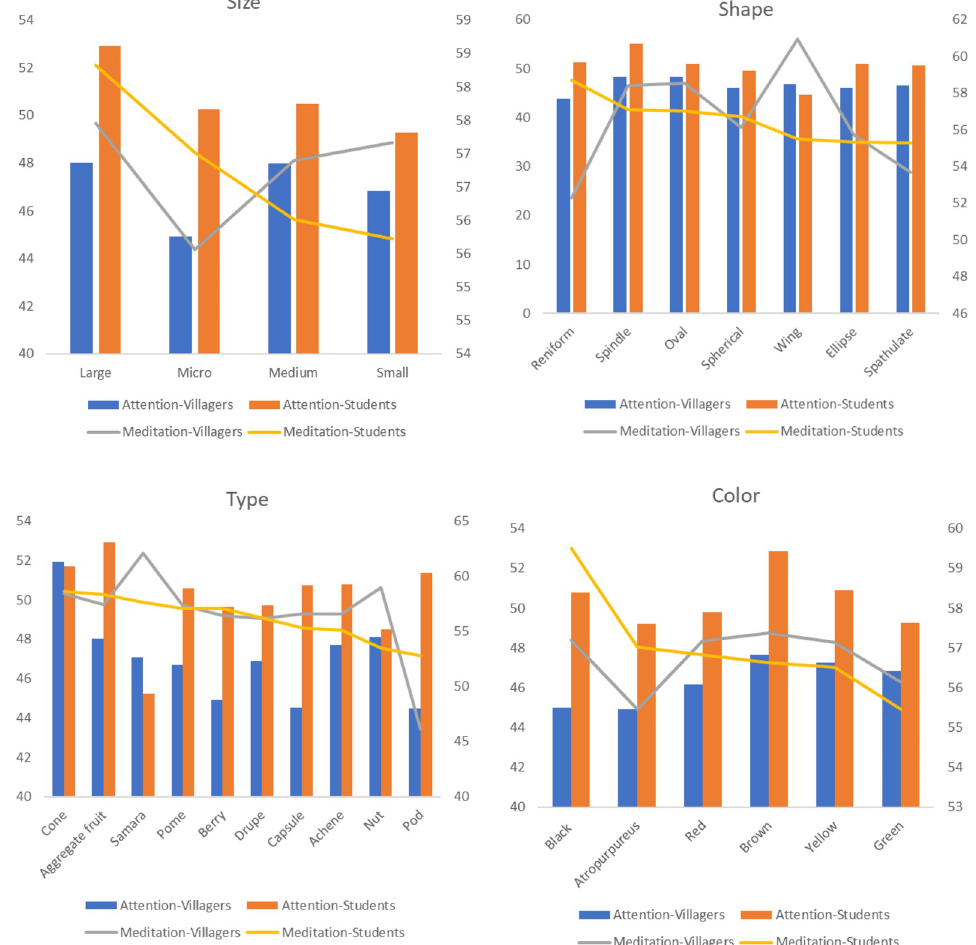
Fig 13. The average value of EEG indicators of different fruit features between villagers and